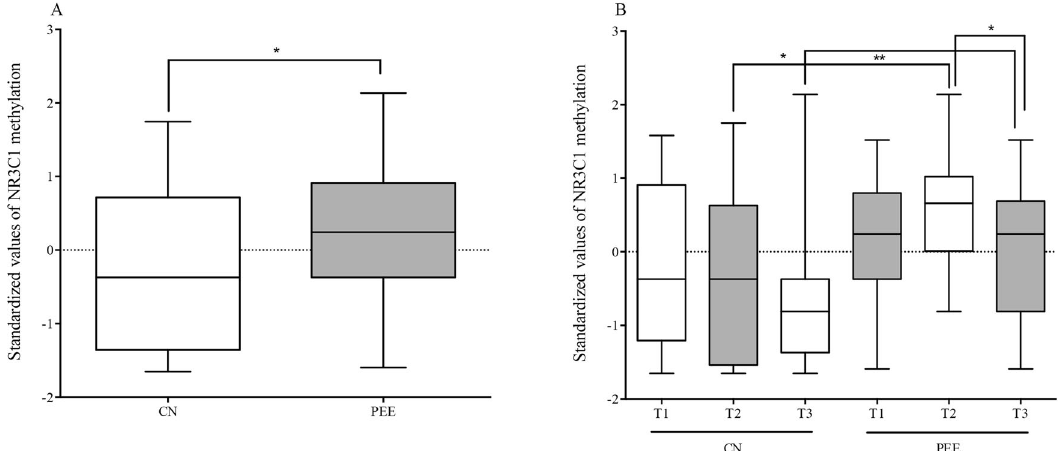
Fig. 2 Box-plot of standardized methylated status in prenatal earthquake exposure and control groups. A A signi fi cant change in the methylated NR3C1 1 F promoter was shown between the two groups. B The signi fi cantly different were detected across subgroups according to different trimesters of gestation when earthquake occurred. CN control group, PEE prenatal earthquake exposure group, T1 fi rst trimester, T2 second trimester, T3 third trimester. * p < 0.05, ** p < 0.01.